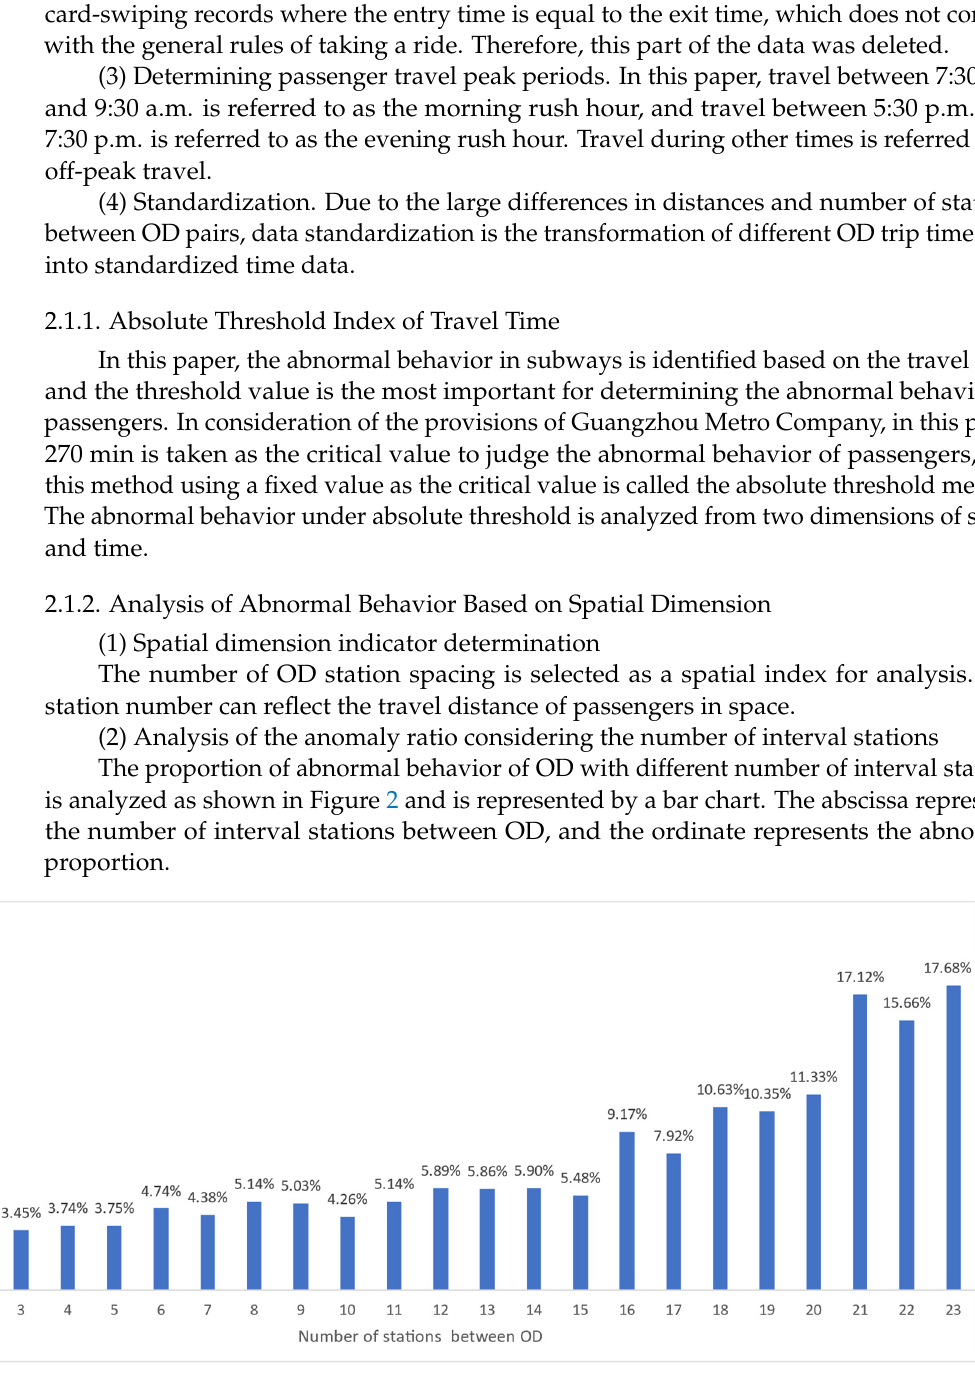
Figure 2. Abnormal percentage of sites.